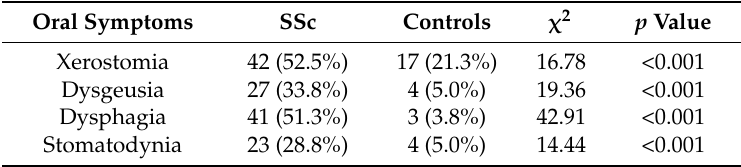
Table 5. Subjective complaints of oral discomfort in SSC patients and